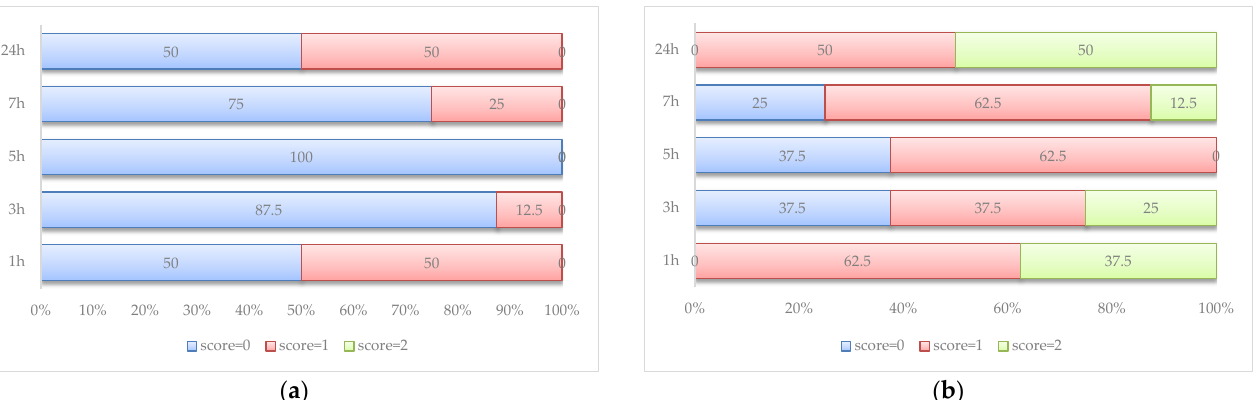
Figure 3. Motility scores (percentages) in AI group ( a ) and AI-D group ( b ) (score 0 = rat walked with difficulty and avoided touching the toes of the inflamed paw to the floor; score 1 = rat walked with little difficulty, but it touched the floor with the toe of the inflamed paw; score 2 = rat walked easily without any difficulties).